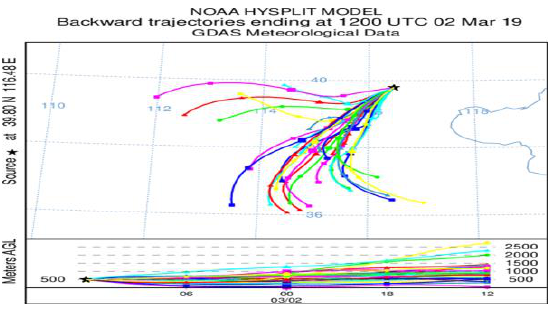
Figure 6. 24-h backward trajectories on 20 March 2019 of Beijing time (=UTC+8)